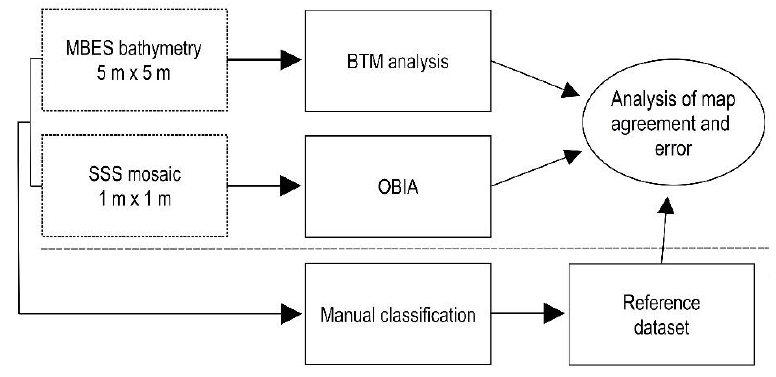
Figure 2. Flow diagram of the analyses.